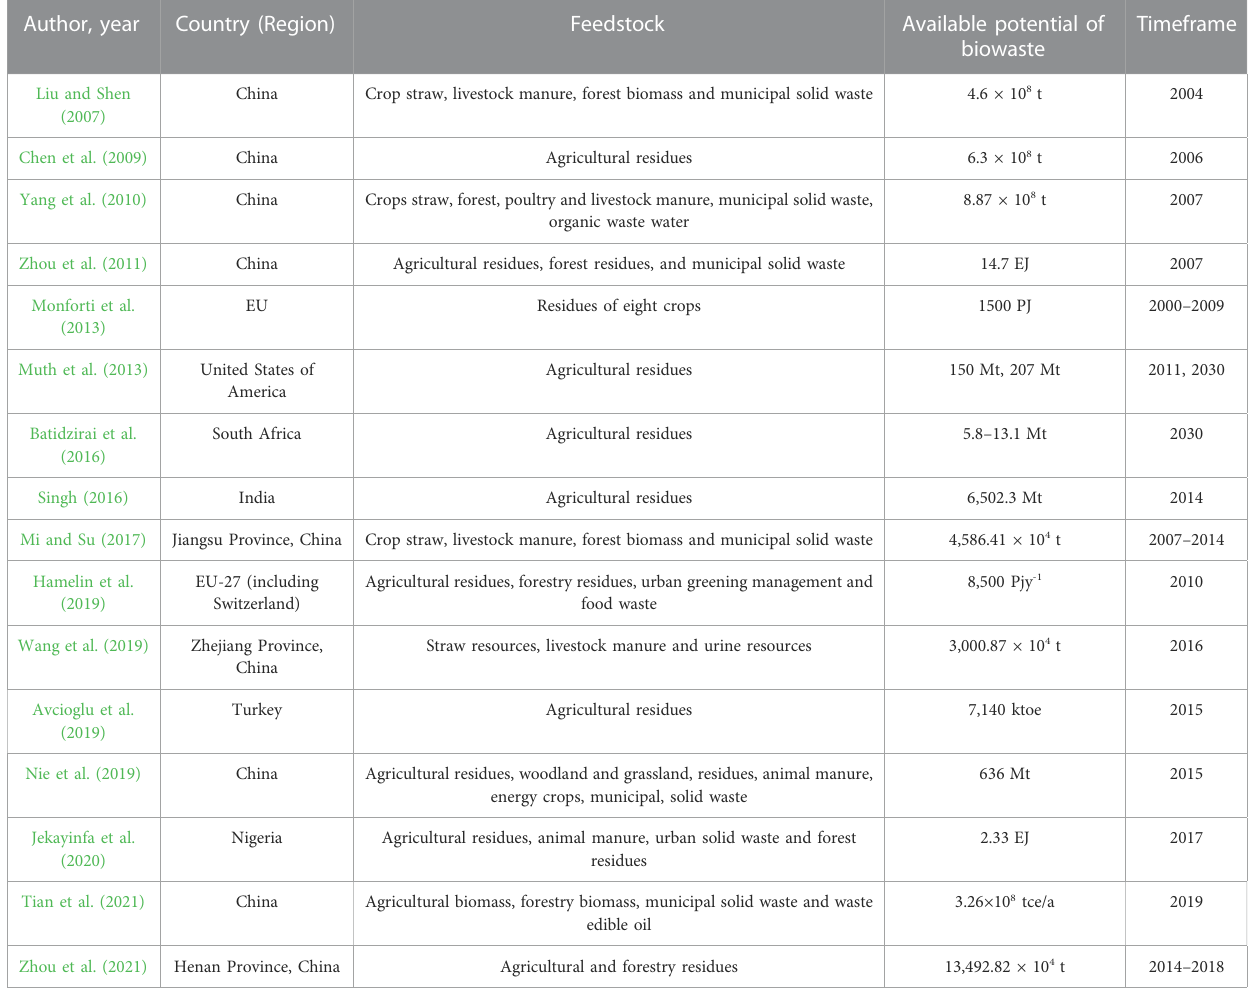
TABLE 1 Summary of biomass energy potential studies in China and other